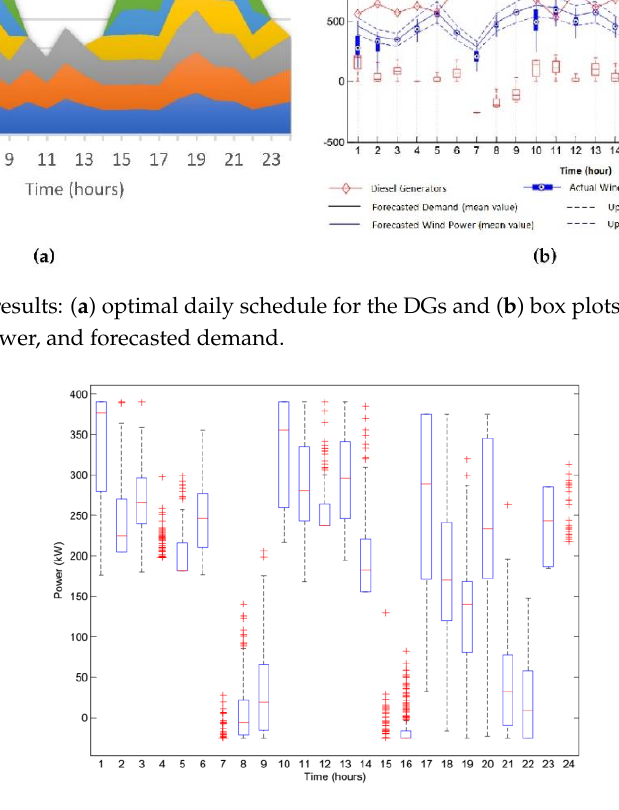
Figure 12. Box plot of the ESS charge/discharge power after a contingency event for Case 2.